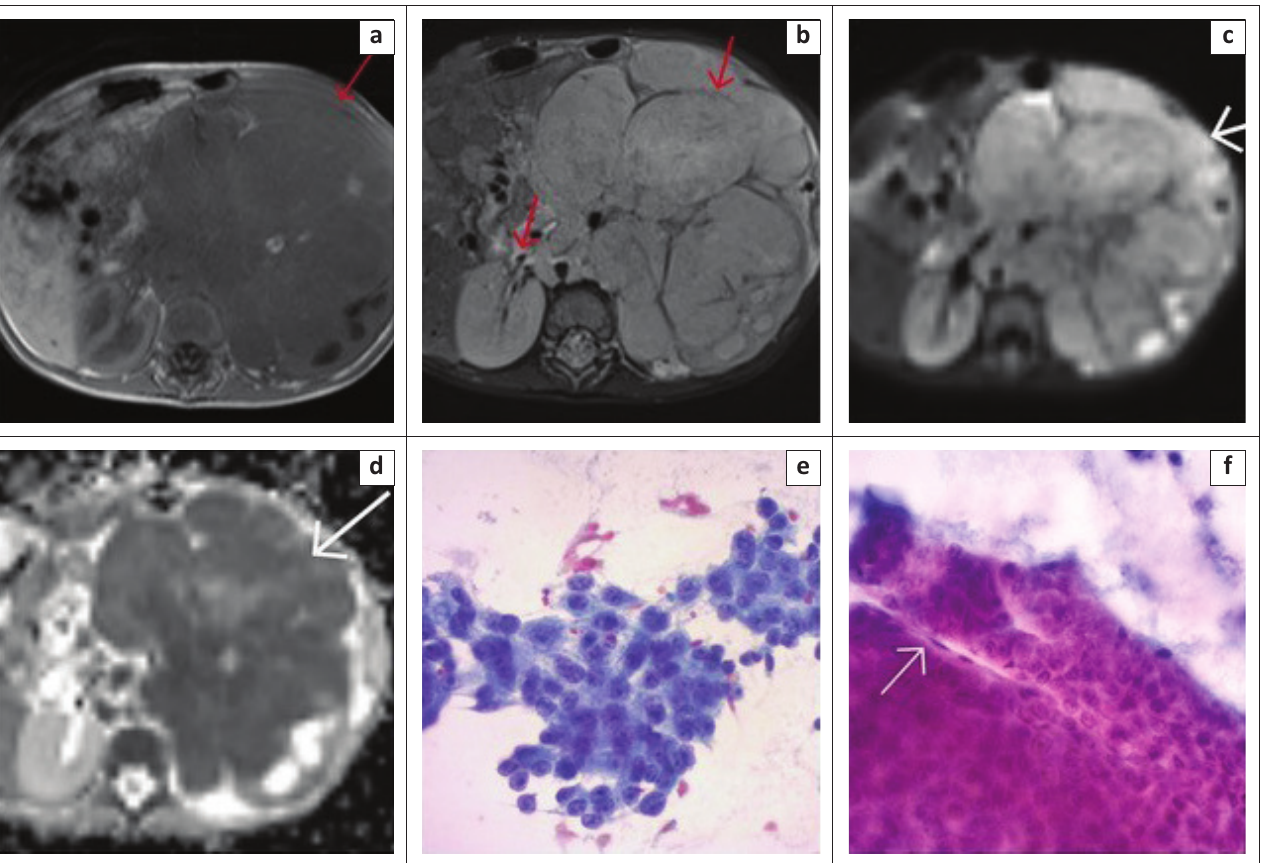
FIGURE 5: (a) T1W and (b) T2W axial images demonstrate a large lobulated left sided heterogeneous intra-abdominal mass (red arrow heads), T1W hypointense, T2W moderately hyperintense with restricted diffusion (high signal on [c] diffusion-weighted imaging with corresponding low signal on [d] apparent diffusion coefficient - white arrow head). The mass encases and displaces vessels (red arrow), crossing the midline to the contralateral side. No infiltration of neural foramina on limited axial slices. (e) Cytology image showing small primitive hepatocytes in a small, cohesive, tissue fragment. The cells are small with minimal cytoplasm, round nuclei with nucleoli (Papanicolaou stain, 40×). (f) A larger tissue fragment showing hepatoblasts growing in sheets and semi-trabeculae. In one area sinusoidal cells line the edge of the trabeculae (sinusoidal rapping) (white arrow) (Papanicolaou stain, 40×).